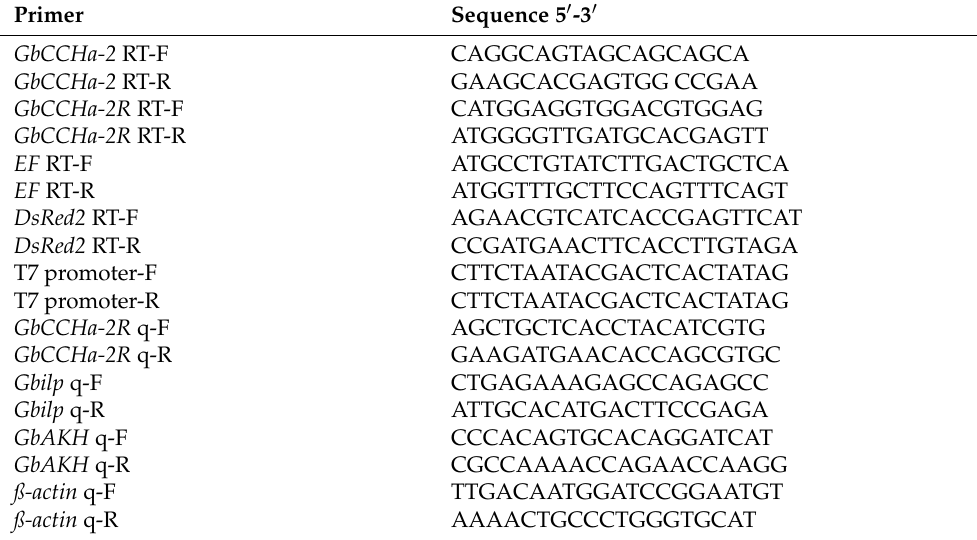
Table 1. Primers used in this